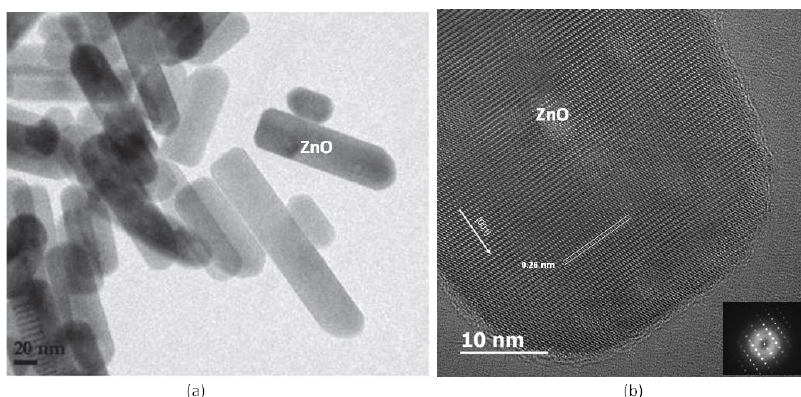
Figure 6. High resolution TEM pictures showing the NR35 ZnO nanorods used as a filler in the anode for GrZnO synthesis: ( a ) low magnification—scale bar 20 nm and ( b ) high magnification—scale bar 10 nm. The lattice spacing of 0.26 nm corresponds to the ZnO (0001) plane. Inset of Figure 6b is the corresponding selected-area electron diffraction (SAED) pattern.